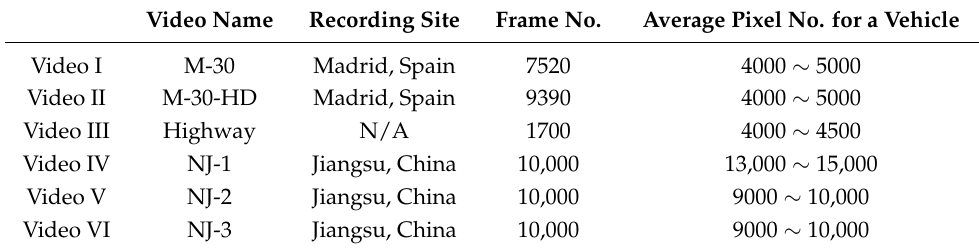
Table 7. Basic information of the videos and the roads.